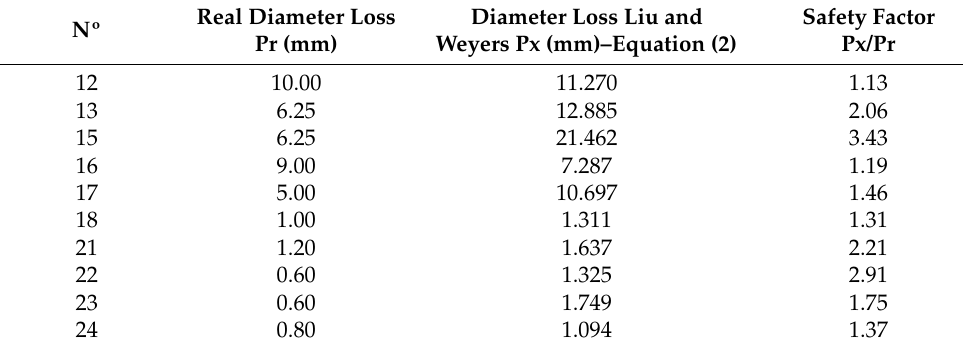
Table 8. Case studies with positive results using the Li (2004 b)